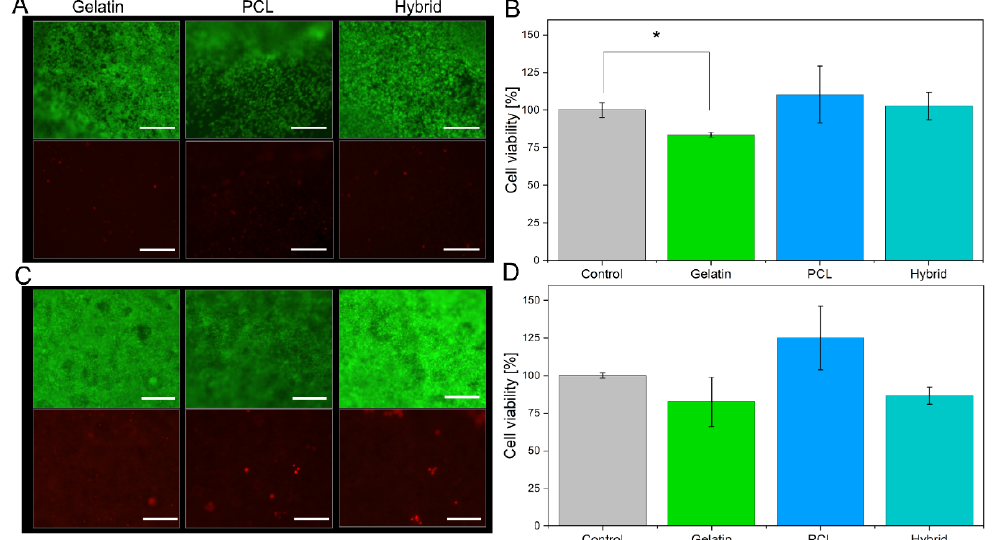
Figure 7. Live–dead staining of cells cultivated on all electrospun scaffolds, with living cells are shown in green (fluorescein diacetate, upper panel), and dead cells are shown in red (propidium iodide, lower panel), as well as the respective alamarBlue ® assays for hBMECs ( A , B ) and hiPS- BCECs ( C , D ). Transwell ® membrane inserts were used as a positive control. The inserts were collagen IV-fibronectin-coated for the cultivation of hiPS-BCECs. Scale bars represent 500 µm ( A ) and 200 µm ( C ). * p < 0.05 for gelatin scaffolds compared to the control.